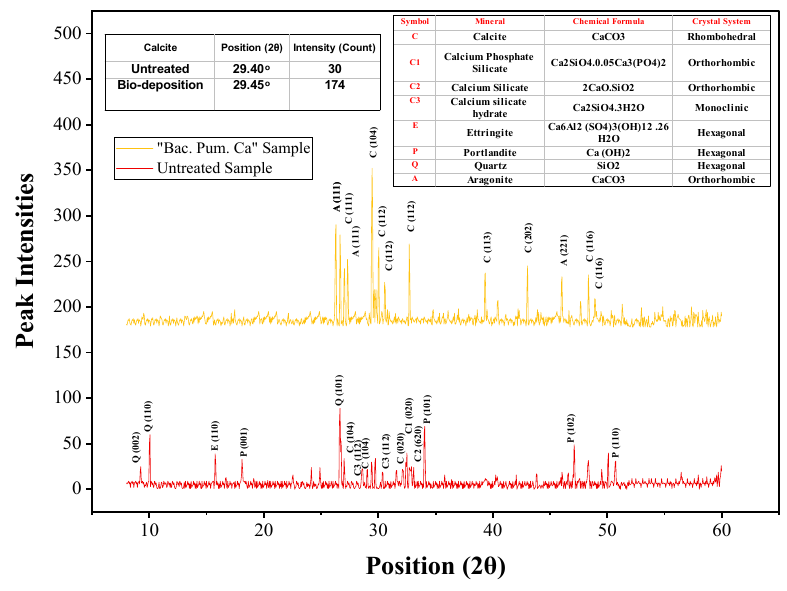
Figure 16. XRD of healing material . Further, the surface morphology and elemental composition of the healing precipi ‐ tate of biodeposition treatment are displayed in Figure 17. Micrographs obtained from SEM analysis resulted in a dense calcite crystal with spherical morphology. The crystal morphology of calcite depends upon the food source and type of bacteria [3]. In this study, an irregularly stacked crystal of calcium carbonate with amorphous morphology was determined. This crystal of calcite perfectly resembles the calcite precipitate report ‐ ed in the literature for Bacillus species with Calcium lactate [5,50]. After morphological confirmation, the elemental composition of these crystals was evaluated using spot ‐ EDS (Figure 17). The elemental mapping obtained in the EDS study was primarily composed of high percentages of C, O 2, and Ca confirming the presence of calcite in healing materi ‐ al [2]. Small percentages of Zn, Si, and Mg were also detected, which could be due to the hydration product of cementitious constitutes in mortar. The high Ca content from the EDS of biodeposition healing products was also verified in the literature [5,10]. Thus, fo ‐ rensic evaluation using RAMAN, XRD, SEM, and EDS confirms the presence of calcite in the healing product of the repaired crack area using biodeposition repair with a Ca source.